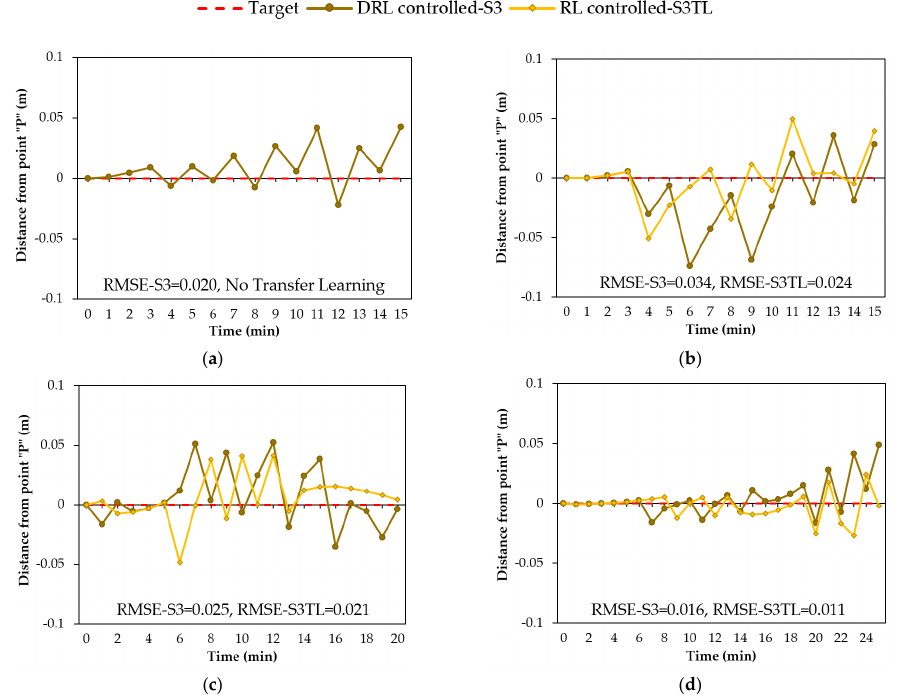
Figure 10. DRL-controlled groundwater with and without the transferred knowledge from a pre- Figure 10. DRL‑controlled groundwater with and without the transferred knowledge from a pre‑ trained model (S3 and S3TL) during rainfall events: ( a ) 15-min-constant; ( b ) 15-min-normal; ( c ) 20- trained model (S3 and S3TL) during rainfall events: ( a ) 15‑min‑constant; ( b ) 15‑min‑normal; ( c ) 20‑ min-descending; ( d ) 25-min-ascending. min‑descending; ( d ) 25‑min‑ascending.